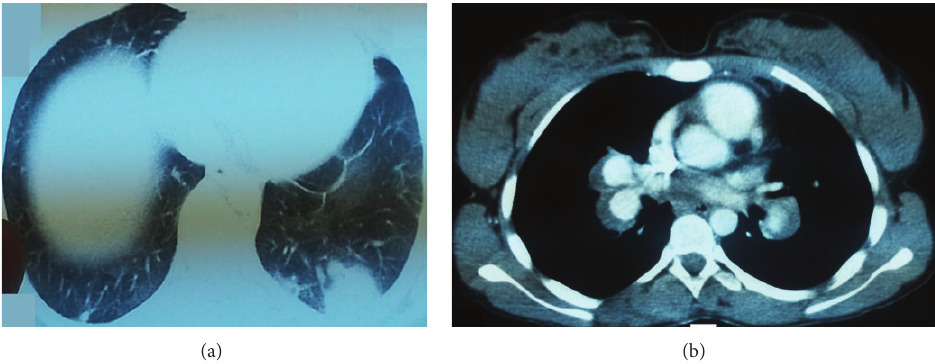
Figure 2: Thorax computed tomogram showing consolidated substances related to emboli in the posterobasal segment of the left pulmonary lower lobe (a), pulmonary artery thrombus and aneurysmal dilatation of the pulmonary artery (b).